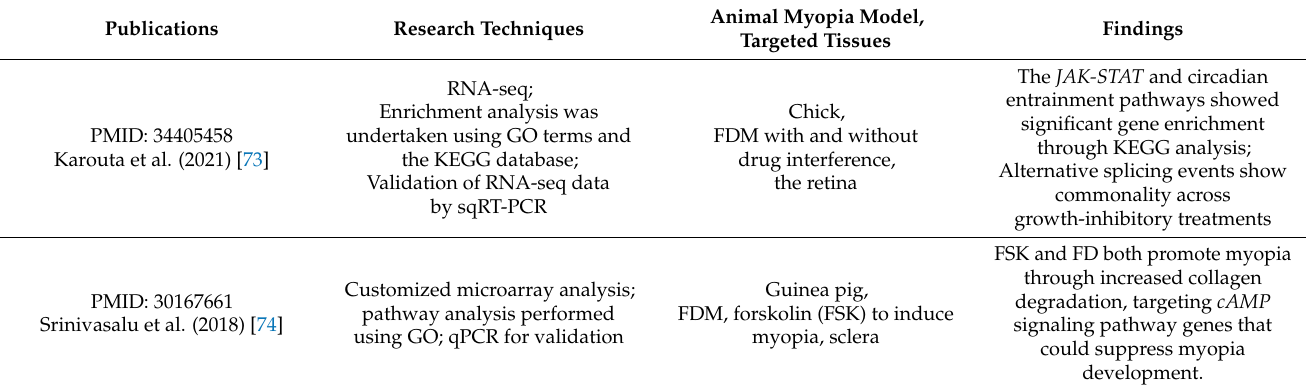
Table 3. Transcriptomics analysis in animal myopia model studies: from a few genes to signaling pathways